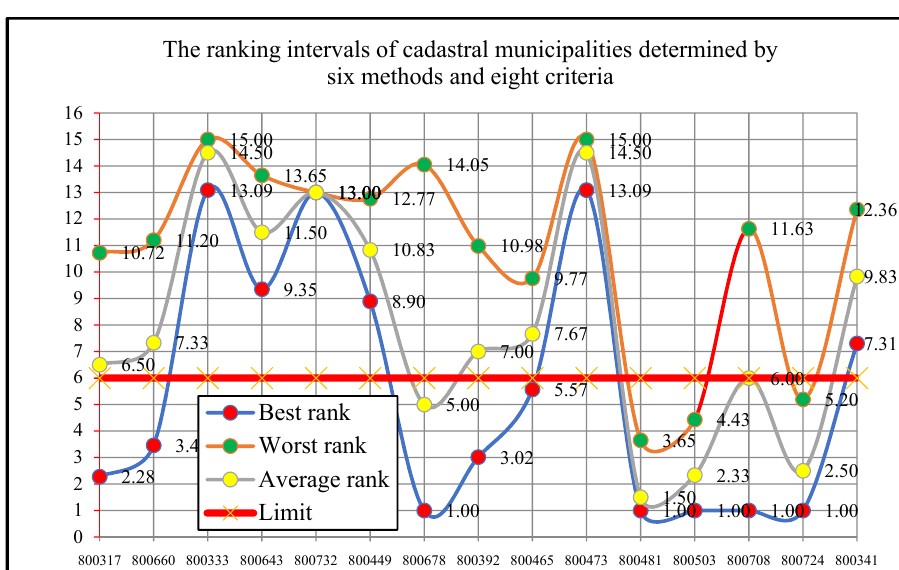
Figure 1. The ranking interval of cadastral municipalities with ten criteria.